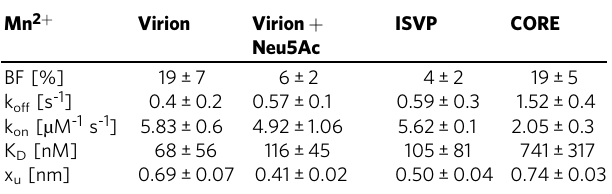
Table 3 Comparison of kinetic and thermodynamic parameters describing β 1 integrin interaction with T3SA + reovirus disassembly